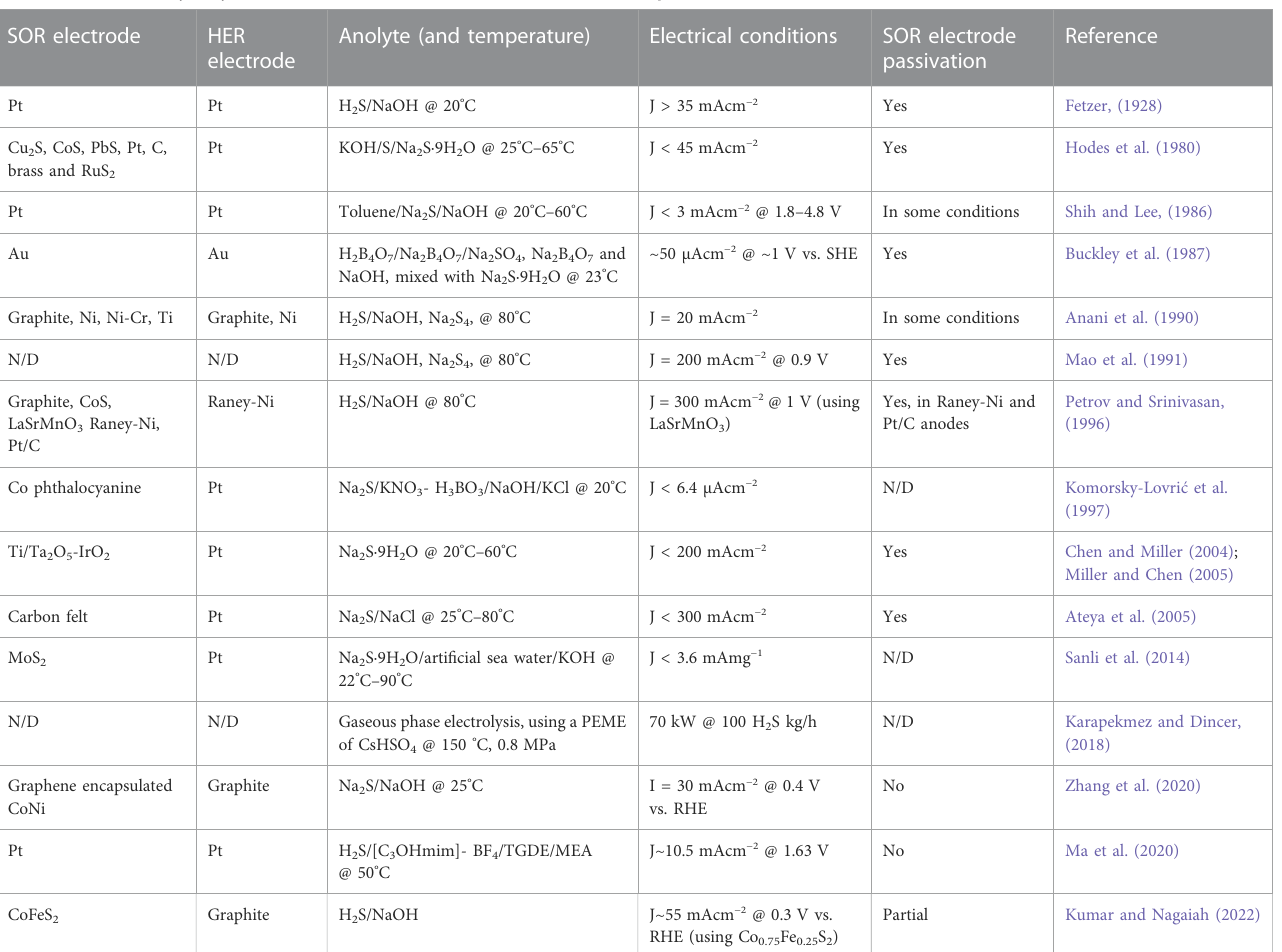
TABLE 1 Direct electrolysis systems used for simultaneous SOR and HER at low temperature. SOR electrode HER Anolyte (and temperature) Electrical electrode